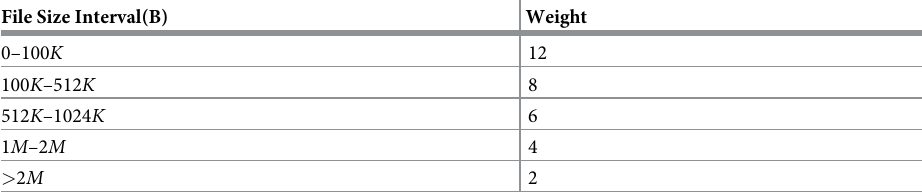
Table 1. Seed file size intervals and